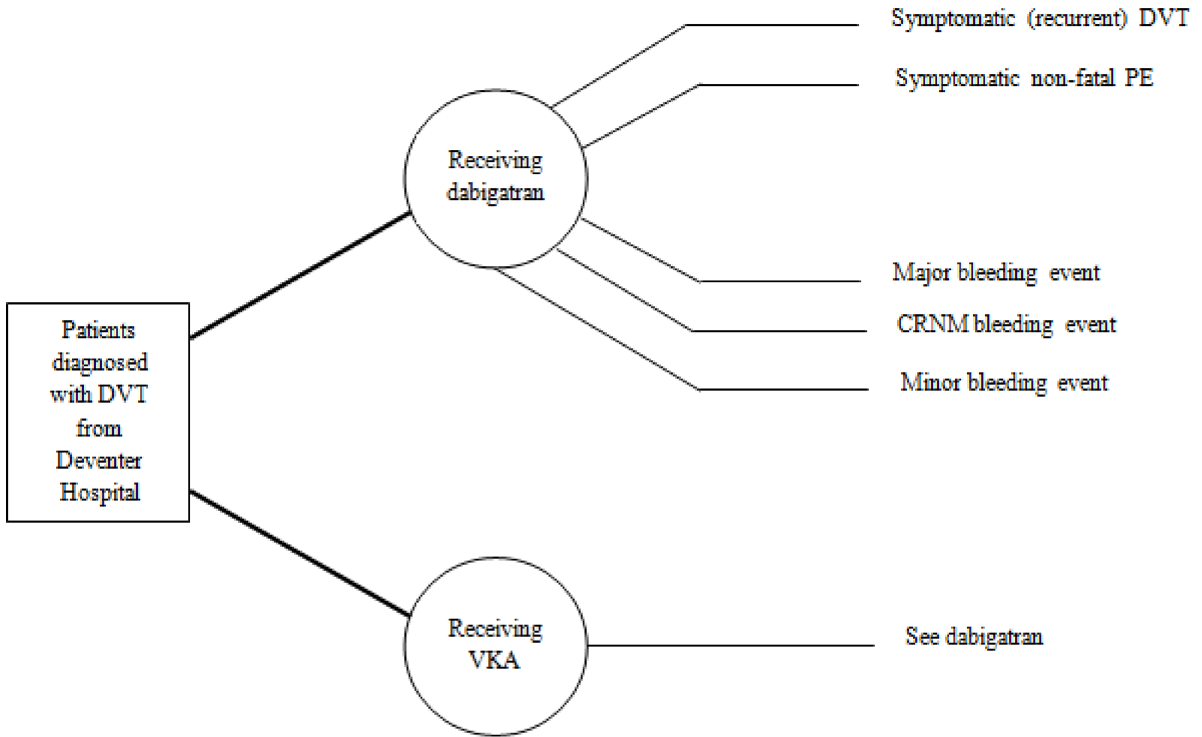
Fig 1. Decision model for the DVT population. The model starts with the diagnosis deep venous thrombosis. All patients directly started with the treatment of VKA or dabigatran anticoagulation, probabilities for events differ per arm. VTE: venous thromboembolism; DVT: deep venous thrombosis; PE: pulmonary embolism; CRNM: clinically relevant